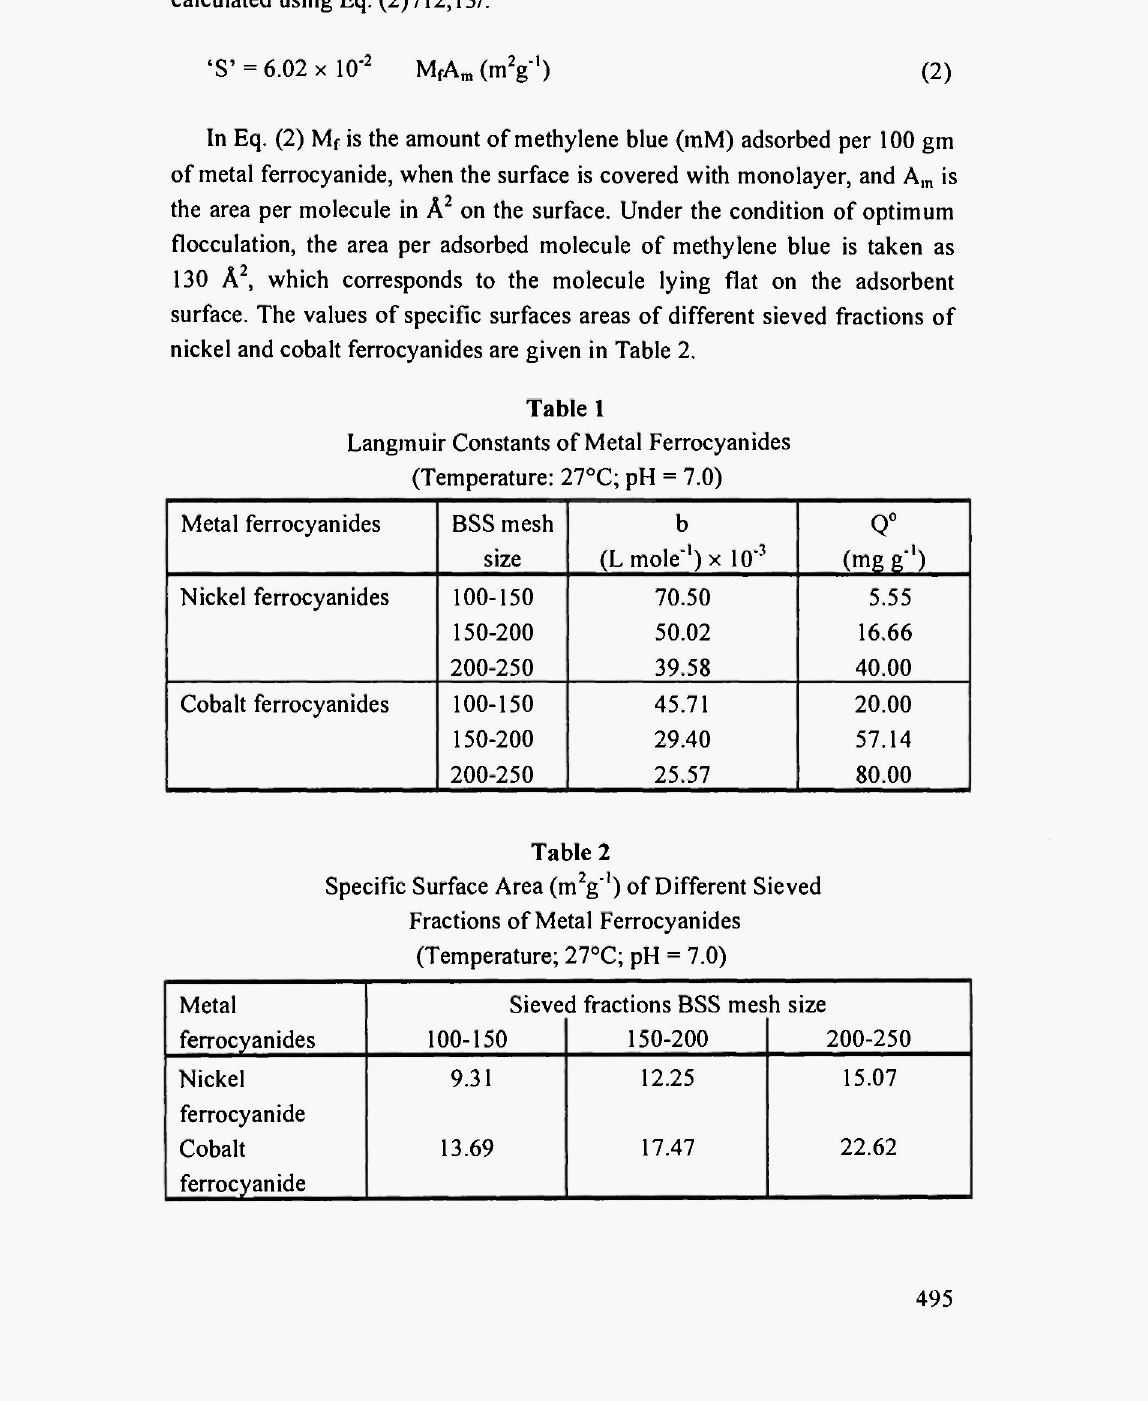
Specific Surface Area (m 2 g"') of Different Sieved Fractions of Metal